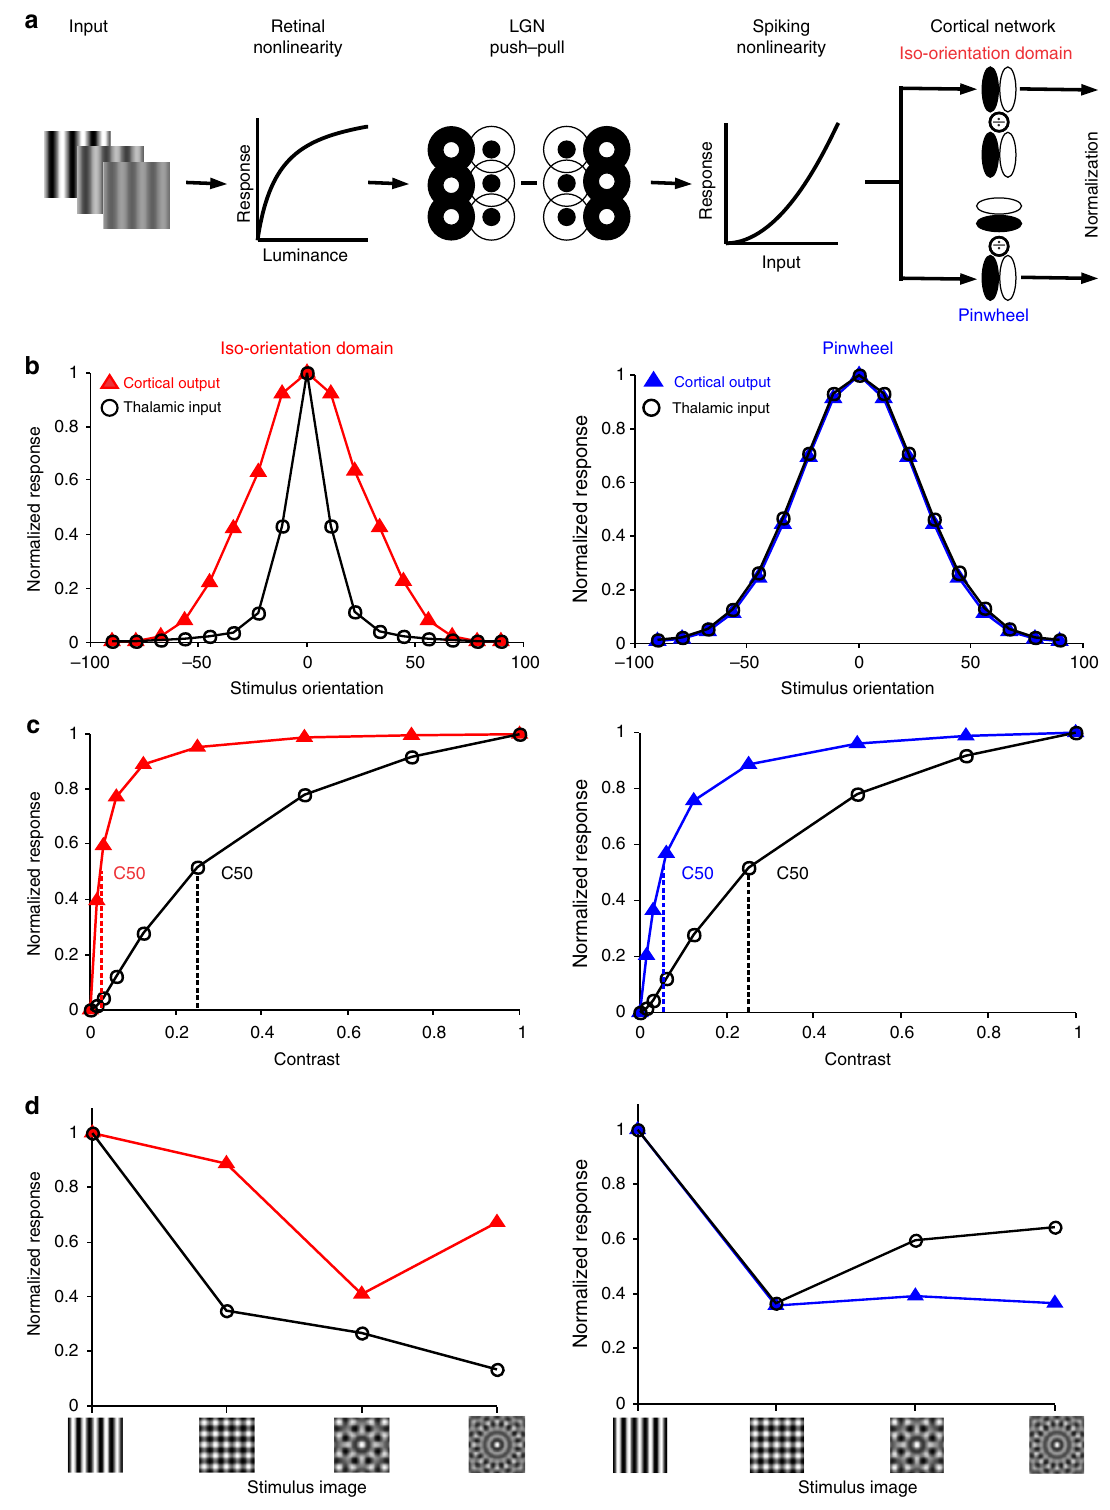
Figure 6 | Cortical normalization model predictions for differences between iso-orientation domains and pinwheel centres. ( a ) Model schematic: inputs were passed through a photoreceptor compressive nonlinearity. The retinal output was convolved with difference-of-Gaussian LGN receptive fields and combined in a push–pull manner to create elongated cortical receptive fields that were run through an expansive spiking nonlinearity. Neighbouring V1 neurons had orientation preferences corresponding to iso-orientation and pinwheel domains. The cortical component is normalization from surrounding oriented neurons with a factor added to the denominator, to keep it from going to zero. ( b – d ) Left: predictions for iso-orientation domain cortical output (red triangles) versus thalamic input for narrowly tuned neurons (black circles). Right: predictions for pinwheel domain cortical output (blue triangles) versus thalamic input for broadly tuned neurons (black circles). ( b ) Orientation tuning. ( c ) Contrast response. ( d ) Responses to images of increasing orientation complexity: preferred grating and plaids of 2, 4 and 8 equally spaced orientations including the